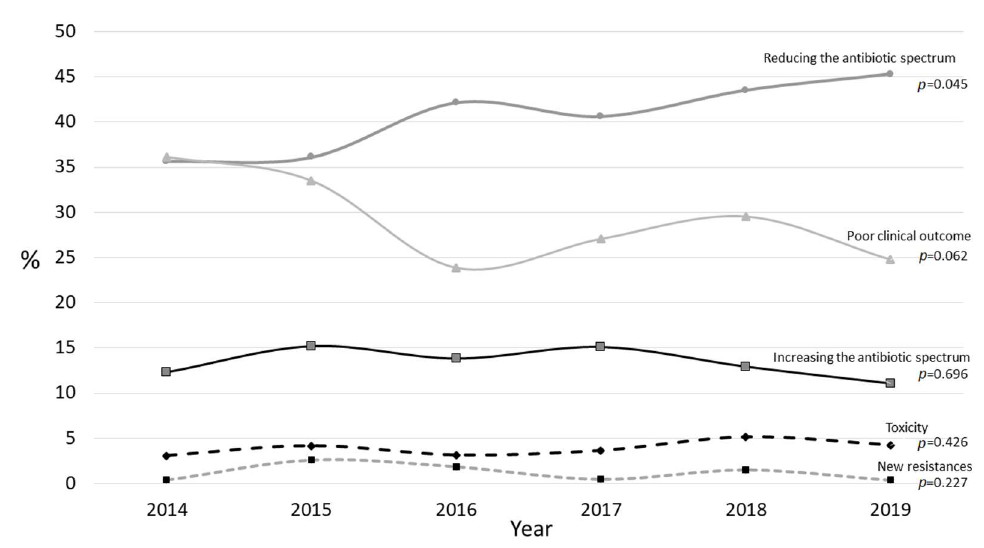
Figure 5. Representation of the evolution of the different reasons for switching antibiotics in those patients who required an adjustment of their antibiotic